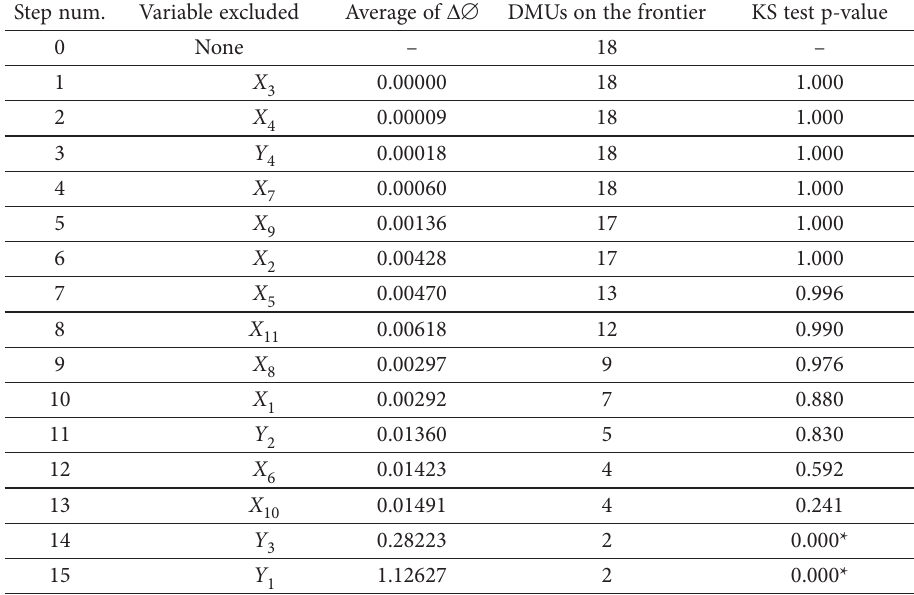
Table 4. Variable elimination using the Wagner and Shimshak (2007) backward stepwise procedure Step